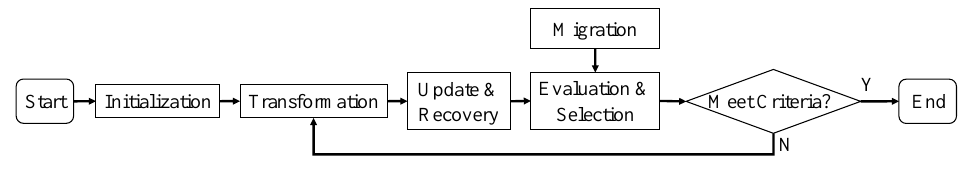
Figure 1. The Flowchart of the AMPO